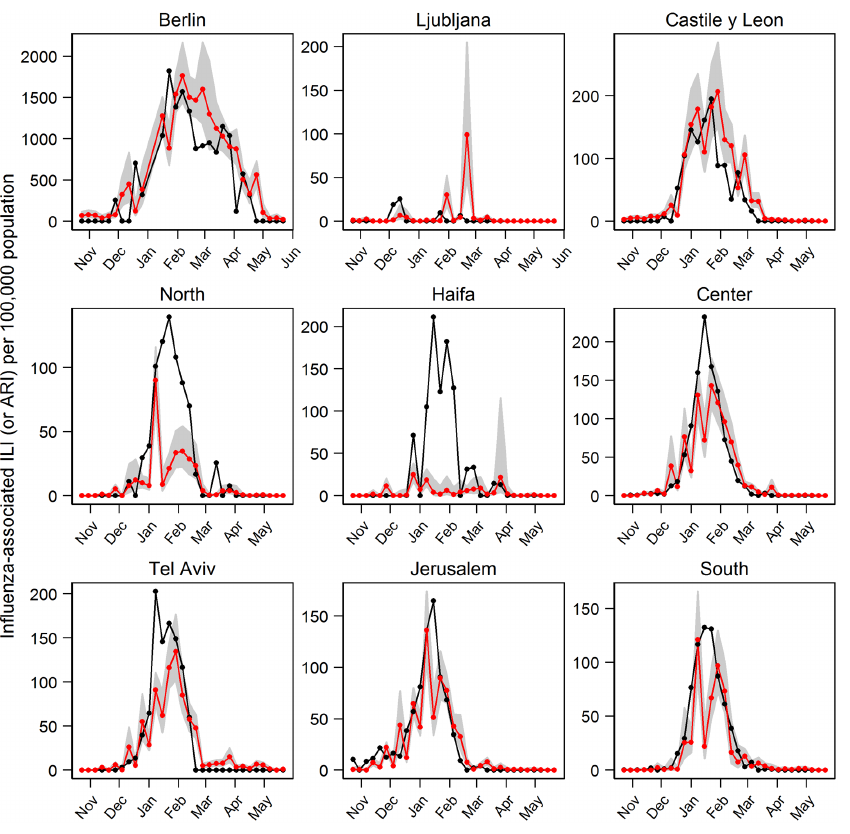
Fig 4. Estimated influenza activity in 2010/2011 season using Model 1 (with specific humidity). Black line is the observations, red line is the predicted influenza and the shaded areas are the 95% CI.